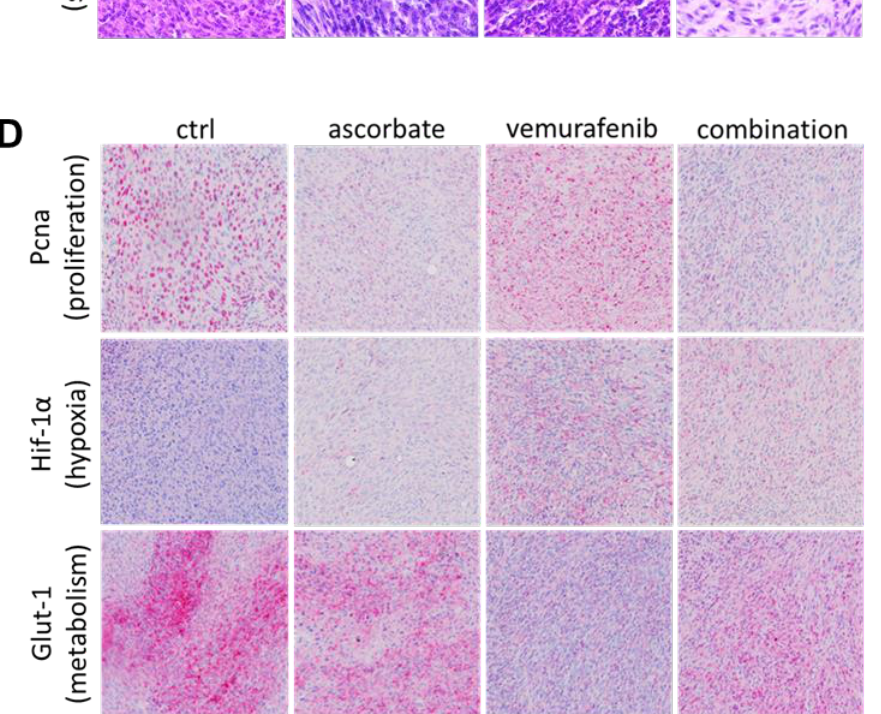
Figure 6. Treatment effects on mouse organs and weight and immunohistochemical analysis of mouse tumors. ( A ) H&E staining of mouse organs (lung, liver, gut, kidney, and spleen) of mice treated with ascorbate (3 g/kg i.p., daily), vemurafenib (30 mg/kg, five times weekly) and their com- bination. ( B ) Weight progress curves of mice during treatment with ascorbate (3 g/kg i.p. daily), vemurafenib (30 mg/kg i.p., five times weekly), and their combination. ( C ) H&E staining of tumors from mice treated with ascorbate (3 g/kg i.p., daily), vemurafenib (30 mg/kg i.p., five times weekly), and their combination. ( D ) Immunohistochemical staining for Pcna, Hif-1α, and Glut-1 of tumors from mice treated with ascorbate (3 g/kg i.p., daily), vemurafenib (30 mg/kg i.p., five times weekly), and their combination. ( E ) Immunofluorescent TUNEL staining of tumors from mice treated with ascorbate (3 g/kg i.p. daily), vemurafenib (30 mg/kg i.p., five times weekly), and their combination. Representative pictures are shown in a magnification of 200-fold. ns: p > 0.05. Taken together, our study showed that ascorbate should be a potent and well-toler- ated additional treatment option for patients afflicted with BRAF mutated melanoma. It does not negatively interfere with the standard (BRAFi) treatment and even enhanced its therapeutic efficacy.